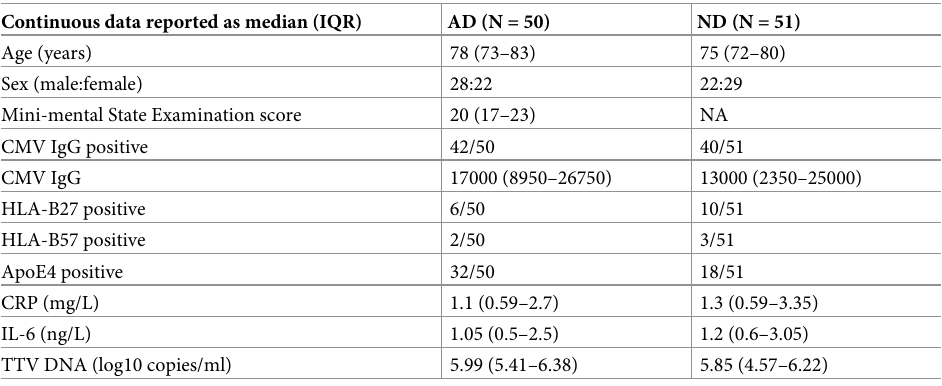
Table 1. Demographics, clinical characteristics and TTV viral